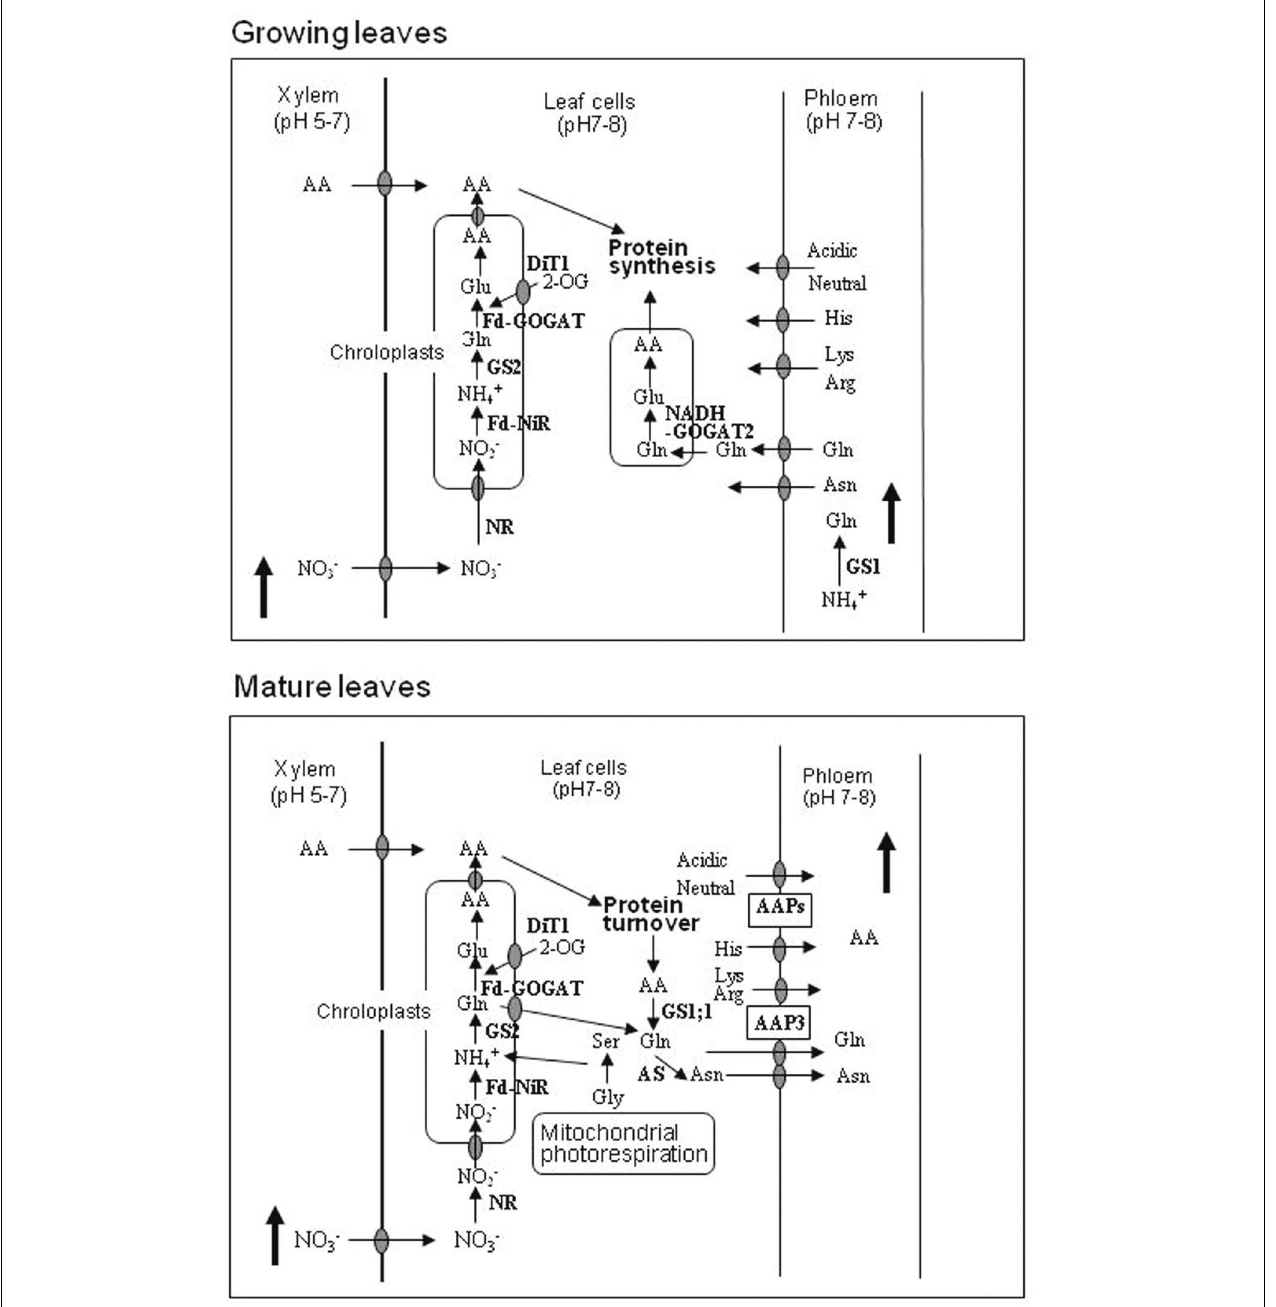
FIGURE 3 | Models for assimilation, metabolism, and transport of N in growing and mature leaves in